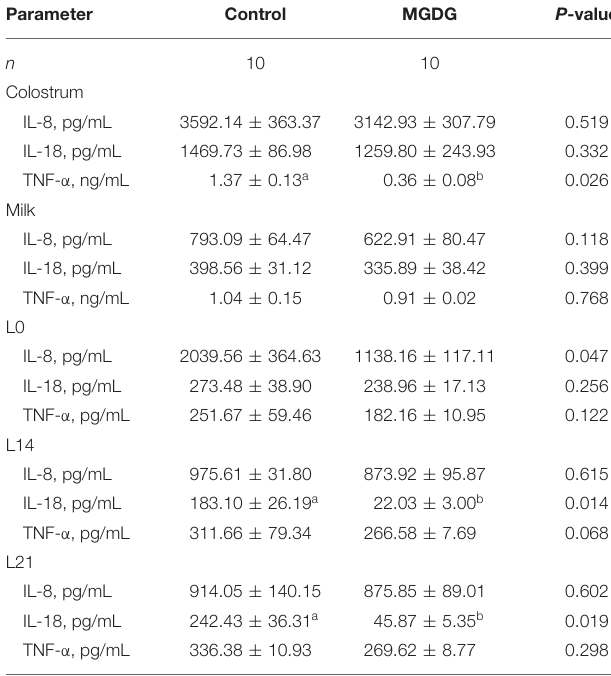
TABLE 5 | Effects of dietary MGDG supplementation during late gestation and lactation on sow colostrum and milk composition. Parameter